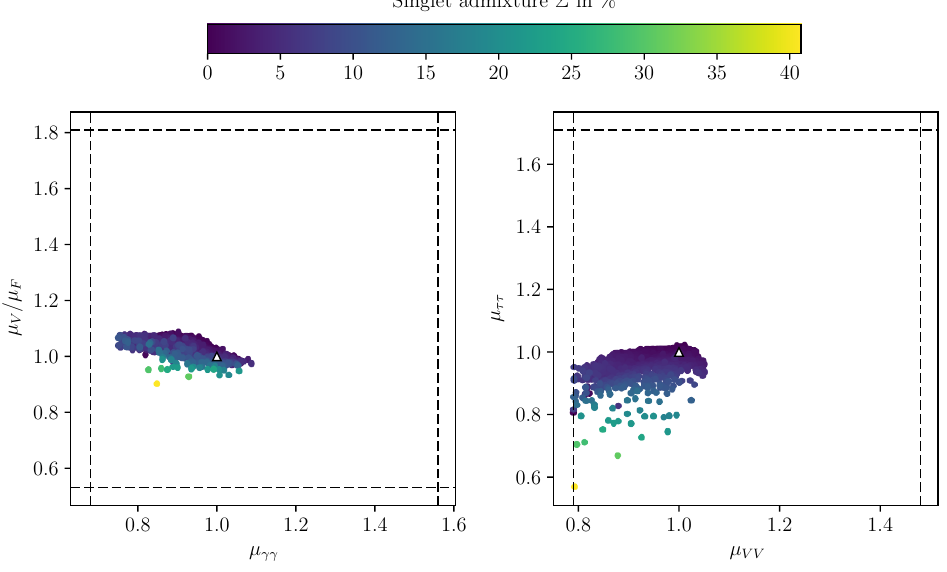
Figure 6 . NMSSM: singlet admixture (cid:6) NMSSM of h 125 as a function of the most constraining signal strengths. The dashed lines show the experimental limits and the white triangle denotes the SM